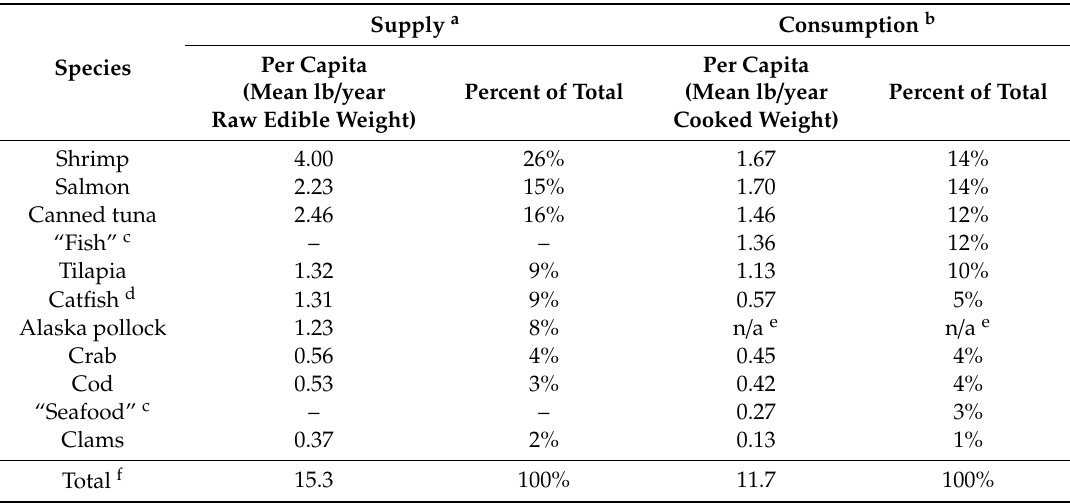
Table 4. Per capita supply (National Marine Fisheries Service (NMFS)) and consumption (NHANES) of top seafood species (2007 to 2016).